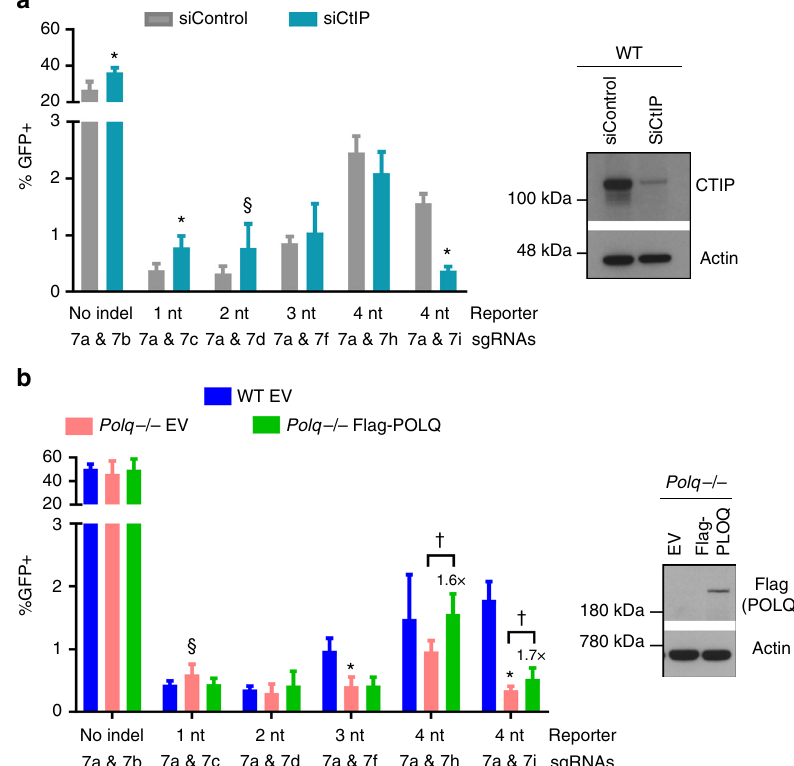
Fig. 4 CtIP and POLQ promote EJ events using 4 nts of embedded microhomology. a WT mESCs with the chromosomally integrated EJ7 and microhomology reporters as in Figs. 1a and 3a were transfected with the respective sgRNA/Cas9 plasmids in the presence of either siControl or siCtIP. Shown is the frequency of the GFP + cells normalized to transfection ef fi ciency. N = 6. Error bars indicate s.d. * p < 0.005, siControl vs. siCtIP using an unpaired t -test with the Holm-Sidak correction. § p < 0.05, but >0.05 when adjusted for multiple comparisons. Also shown is immunoblotting analysis con fi rming CTIP depletion in WT mESCs. b The EJ7 and microhomology reporters as in Fig. 3a were integrated into Polq − / − mESCs, and were transfected with sgRNA/Cas9 plasmids along with a control (EV) or complementation vector. Shown is the frequency of GFP + cells normalized to transfection ef fi ciency. The frequencies for WT mESCs are the same as in Figs. 1b and 3b. N ≥ 6 for Polq − / − mESCs and N = 6 for WT mESCs. Error bars indicate s.d. * p < 0.002, WT vs. Polq − / − mESCs using an unpaired t -test with the Holm-Sidak correction. § p < 0.05, but >0.05 when adjusted for multiple comparisons. † p < 0.01, control EV vs. complemented using an unpaired, two-tailed t -test. Also shown is immunoblotting analysis con fi rming expression of